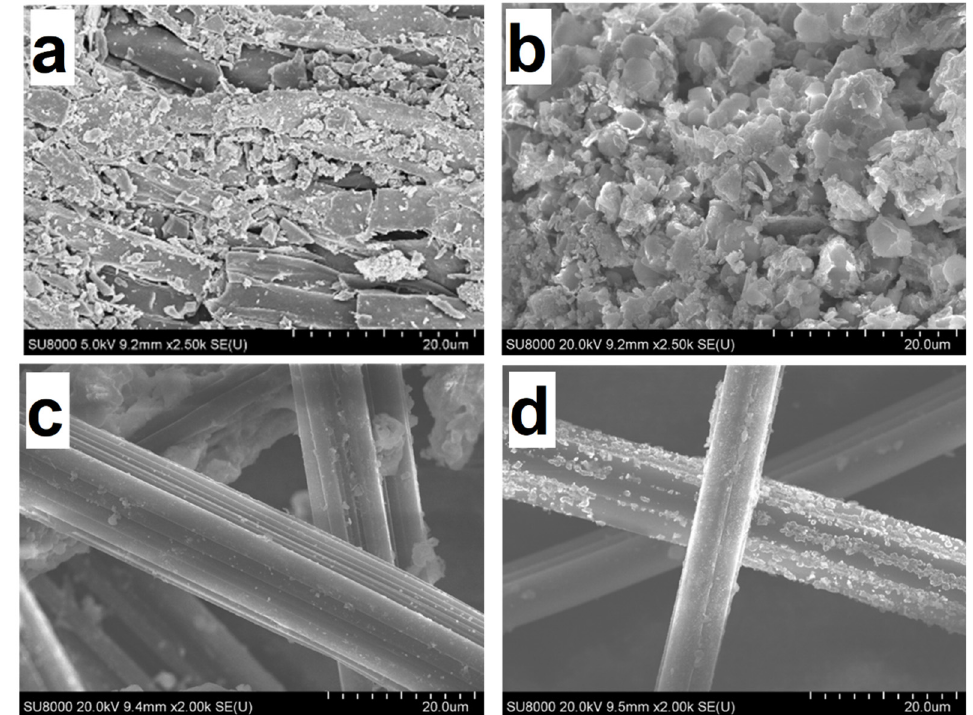
Figure 2. SEM images of ( a ) KCoMoS 2 /DAS; ( b ) KCoMoS 2 /YPK-1, ( c ) KCoMoS 2 /AHM, and ( d ) KCoMoS 2 /TCA.